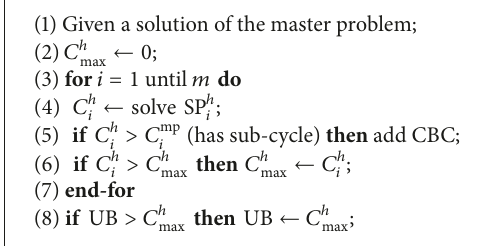
Algorithm 1: Subproblem